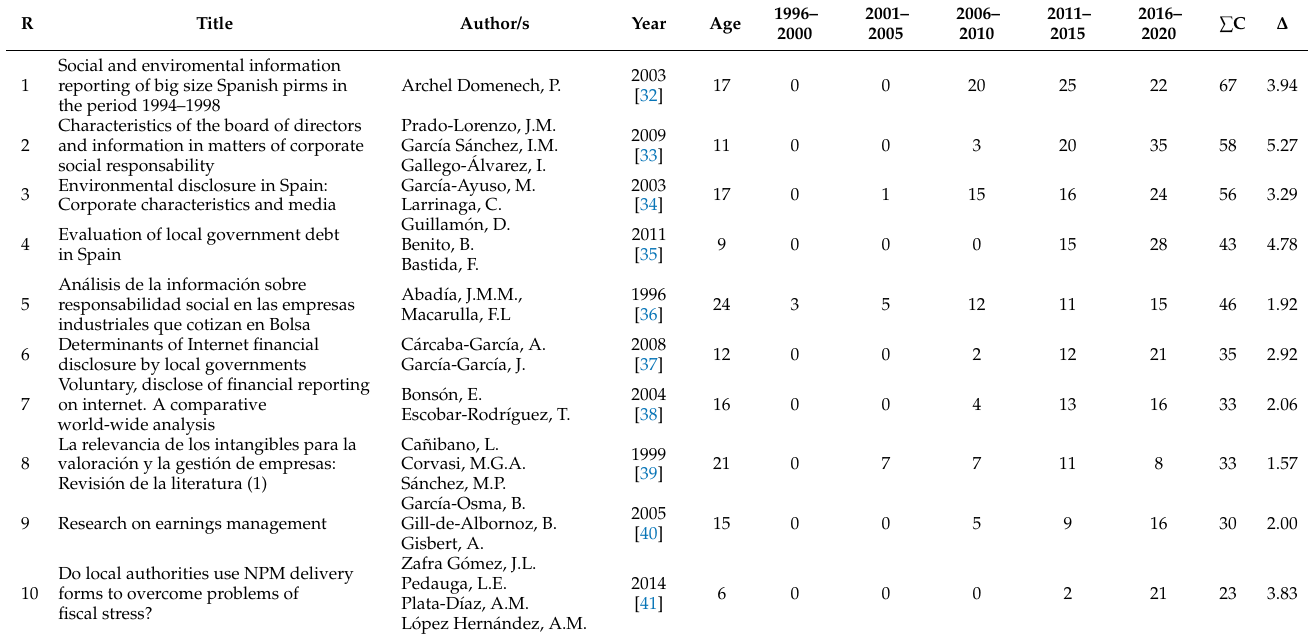
Table 5. Ranking and detail of citations of the documents published in SJFA with more than 20